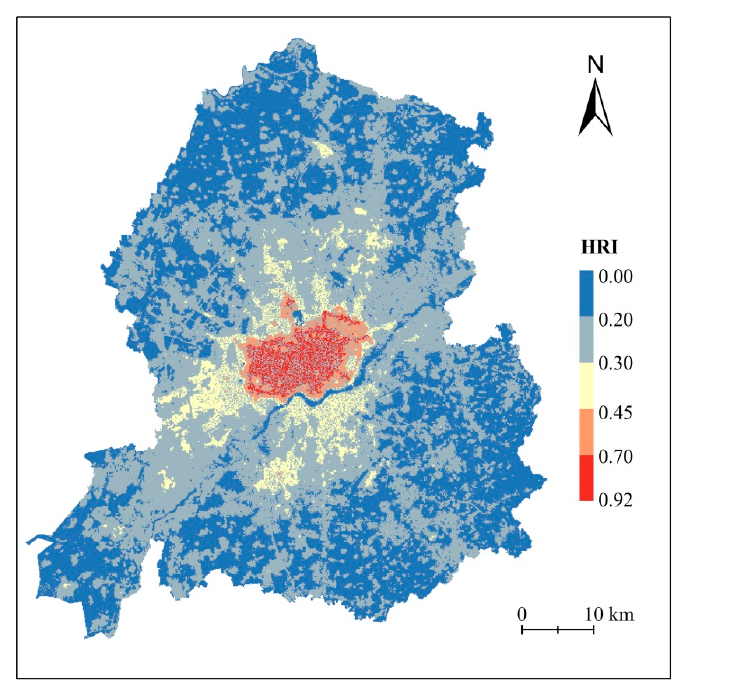
Figure 9. Spatial distribution of heat risk index.